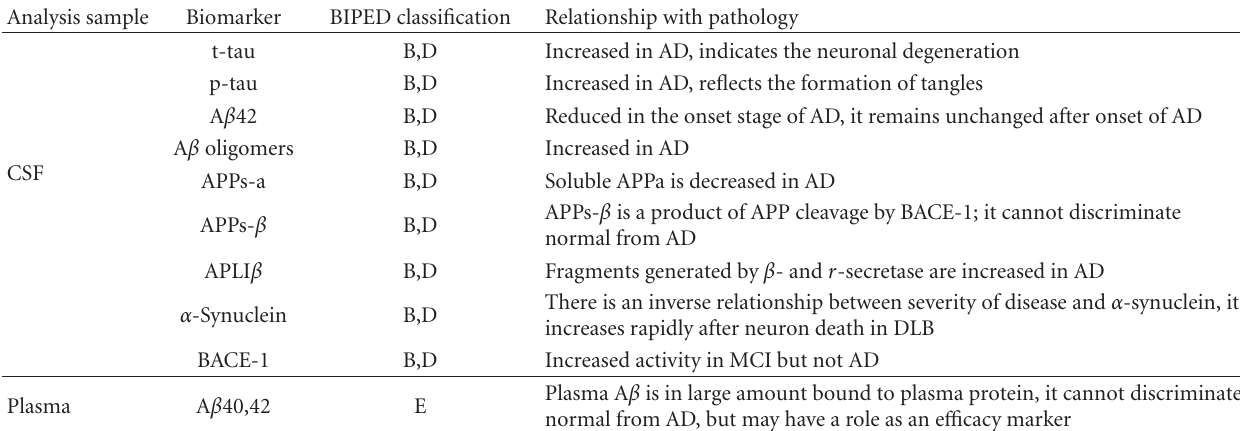
Table 3: Present fluid biomarkers for dementias from [15, 33,